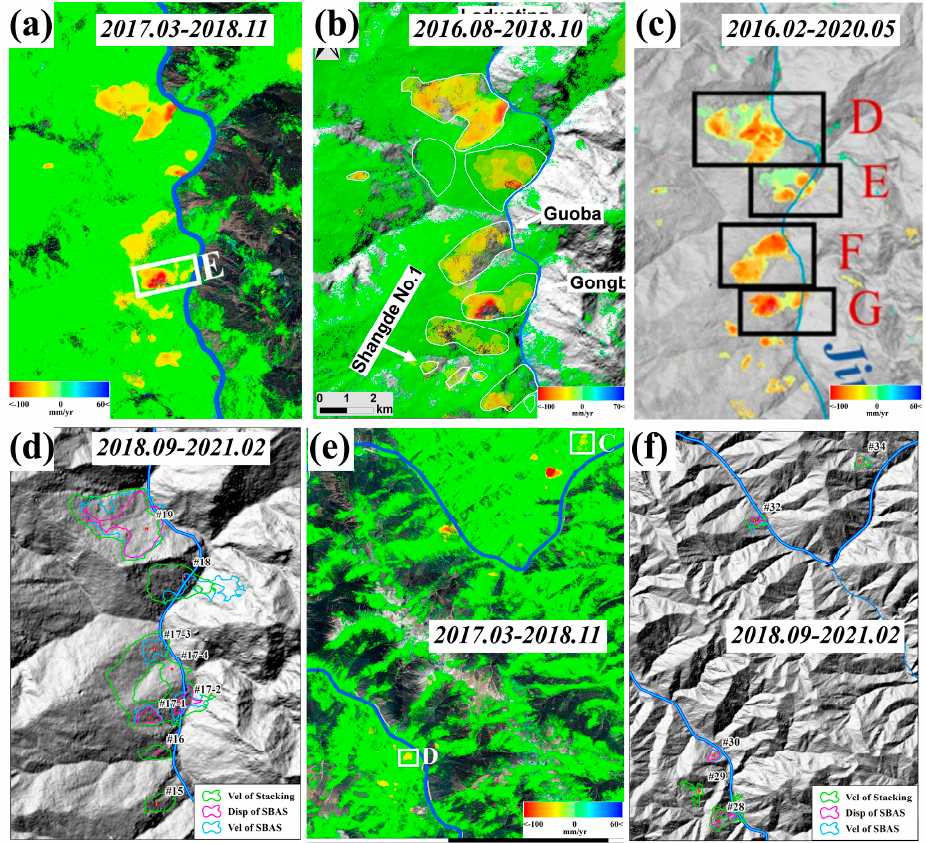
Figure 16. Comparison with other research results; the deformation period time is marked. ( a , b , e ) Results obtained by Liu et al. [18,38]. ( c ) Results obtained by Zhang et al. [39]. ( d , f ) Results obtained in the present study. The legend of the original text in the figure was redrawn.